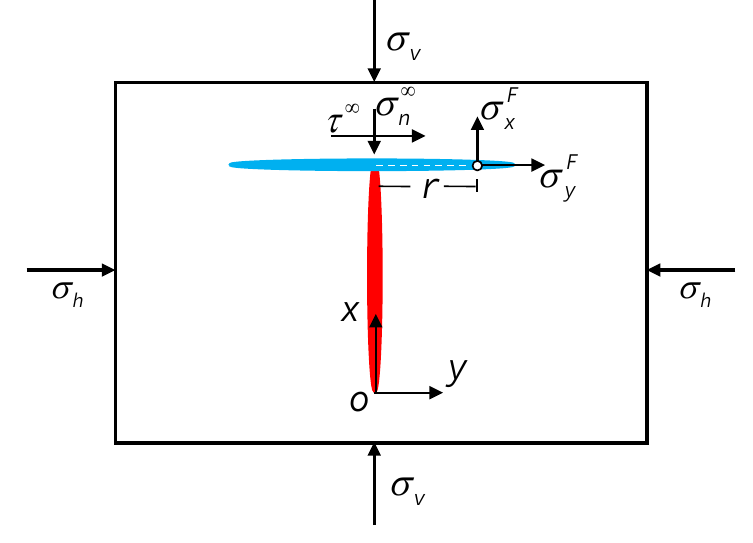
Figure 3. Physical model of T-type fracture.